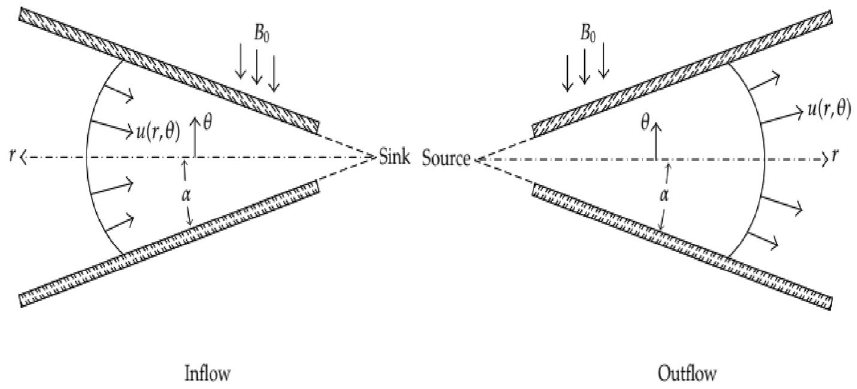
Figure 1. The schematic flow model through convergent (inflow) and divergent (outflow)